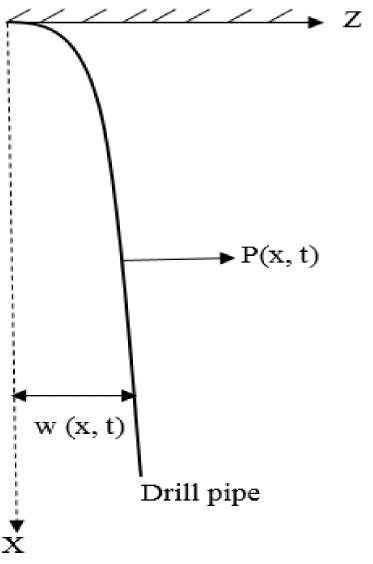
Figure 1. Vibrational